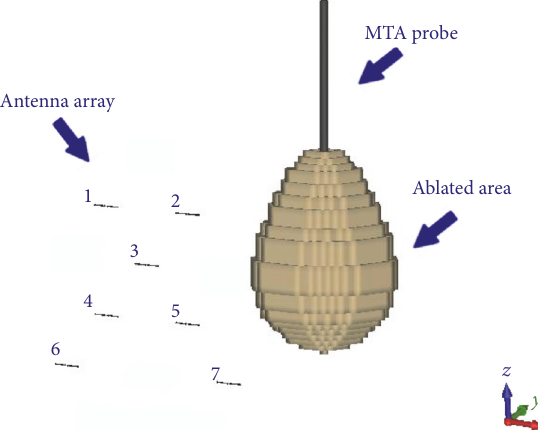
Figure 2: Representation of the simulated scenario. The MTA applicator is modeled as a metallic cylinder in the center of the tissue. The measurement configuration consists of 7 dipoles evenly spaced on a plane parallel to the MTA antenna